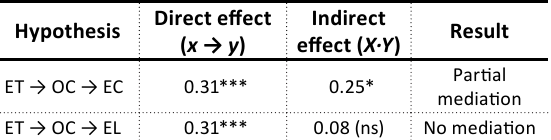
Table 9. Details of mediation